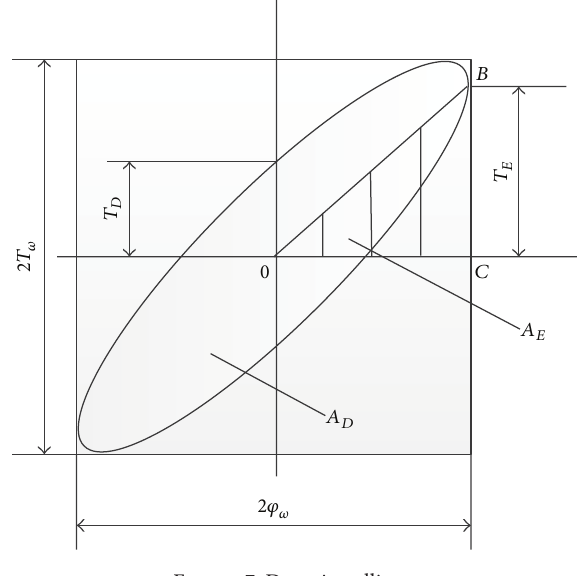
Figure 7: Damping ellipse.